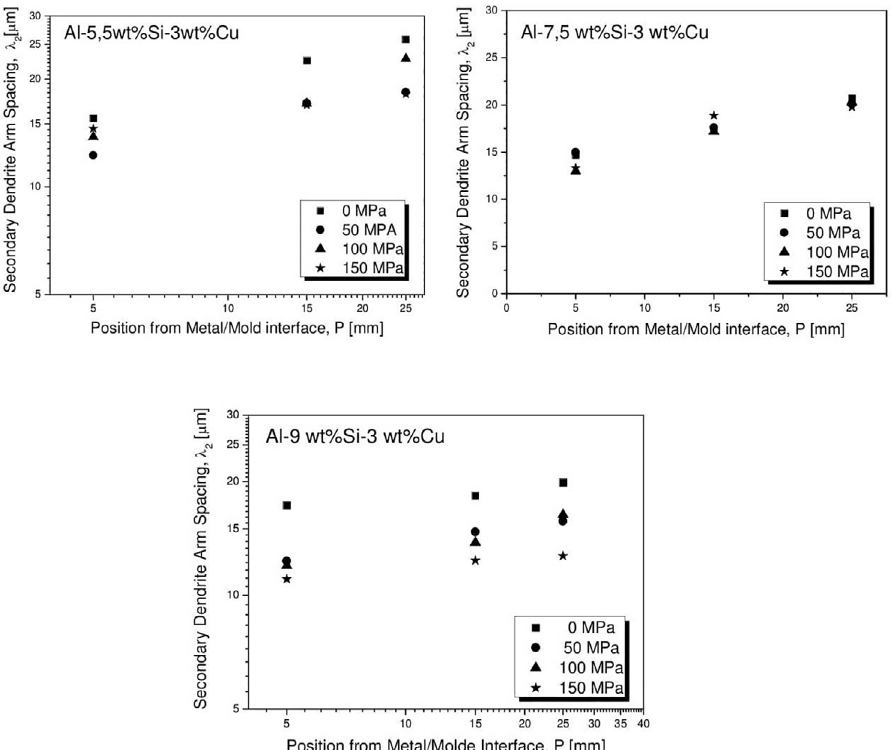
Figure 5. Correlation between the secondary dendrite arm spacing with position from metal/mold interface.